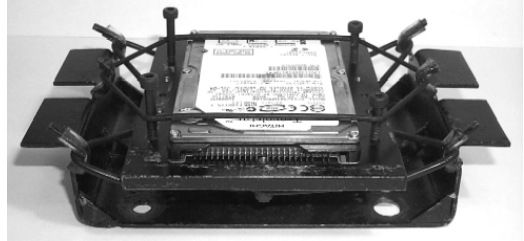
Fig. 14. Components of vibration isolator system II.